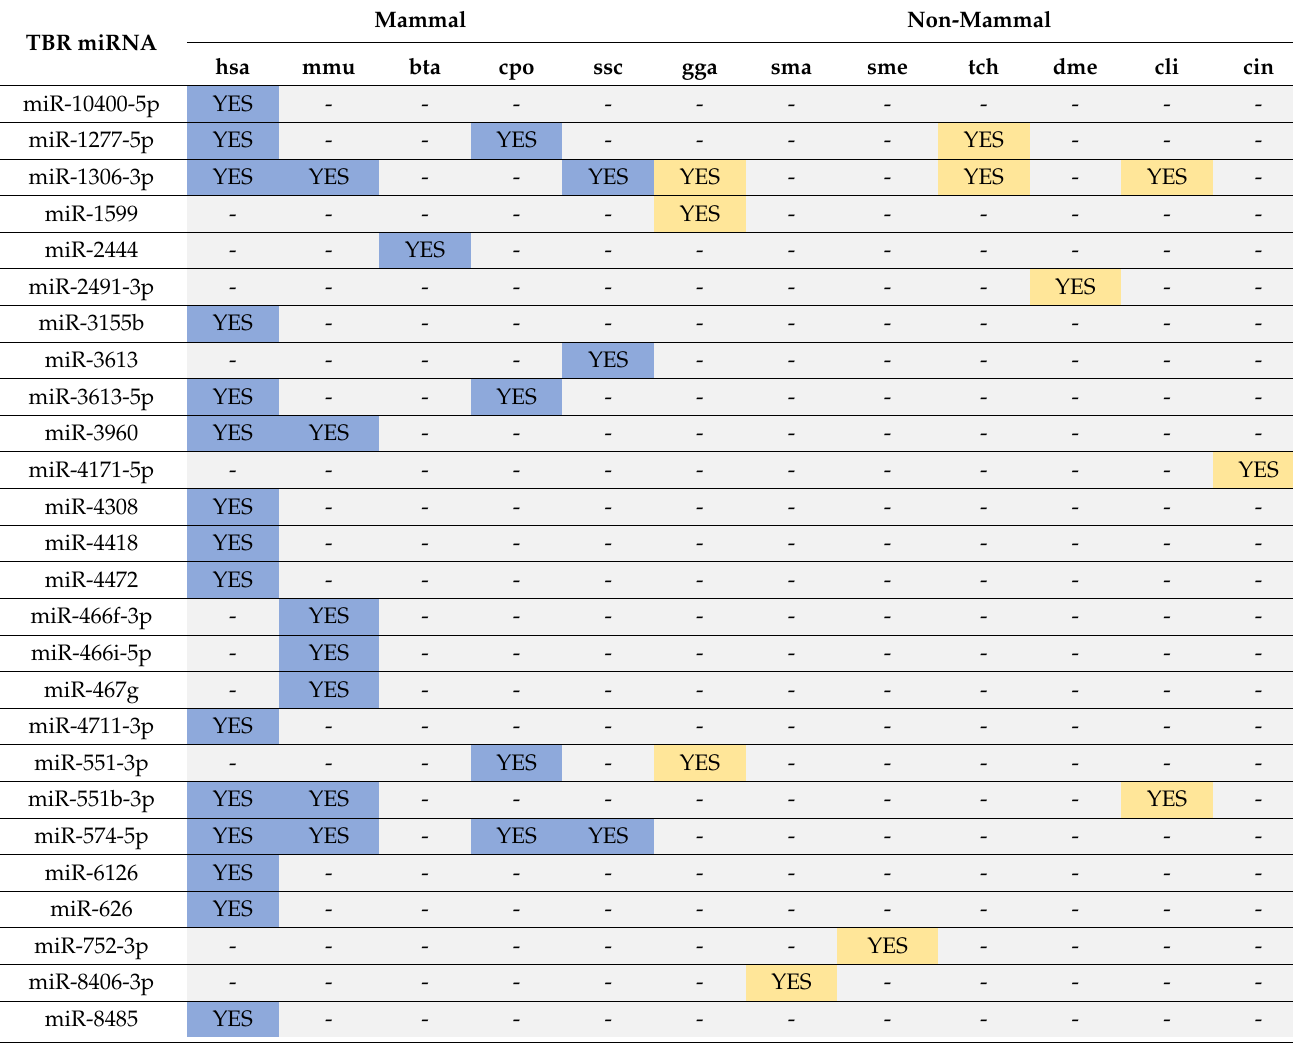
Table 4. Homolog distribution of identified miRNA when compared to other species. The block “YES” indicated that the homolog of corresponding miRNA was present in the corresponding species. The blue block indicated the mammals, while yellow block indicated the non-mammal